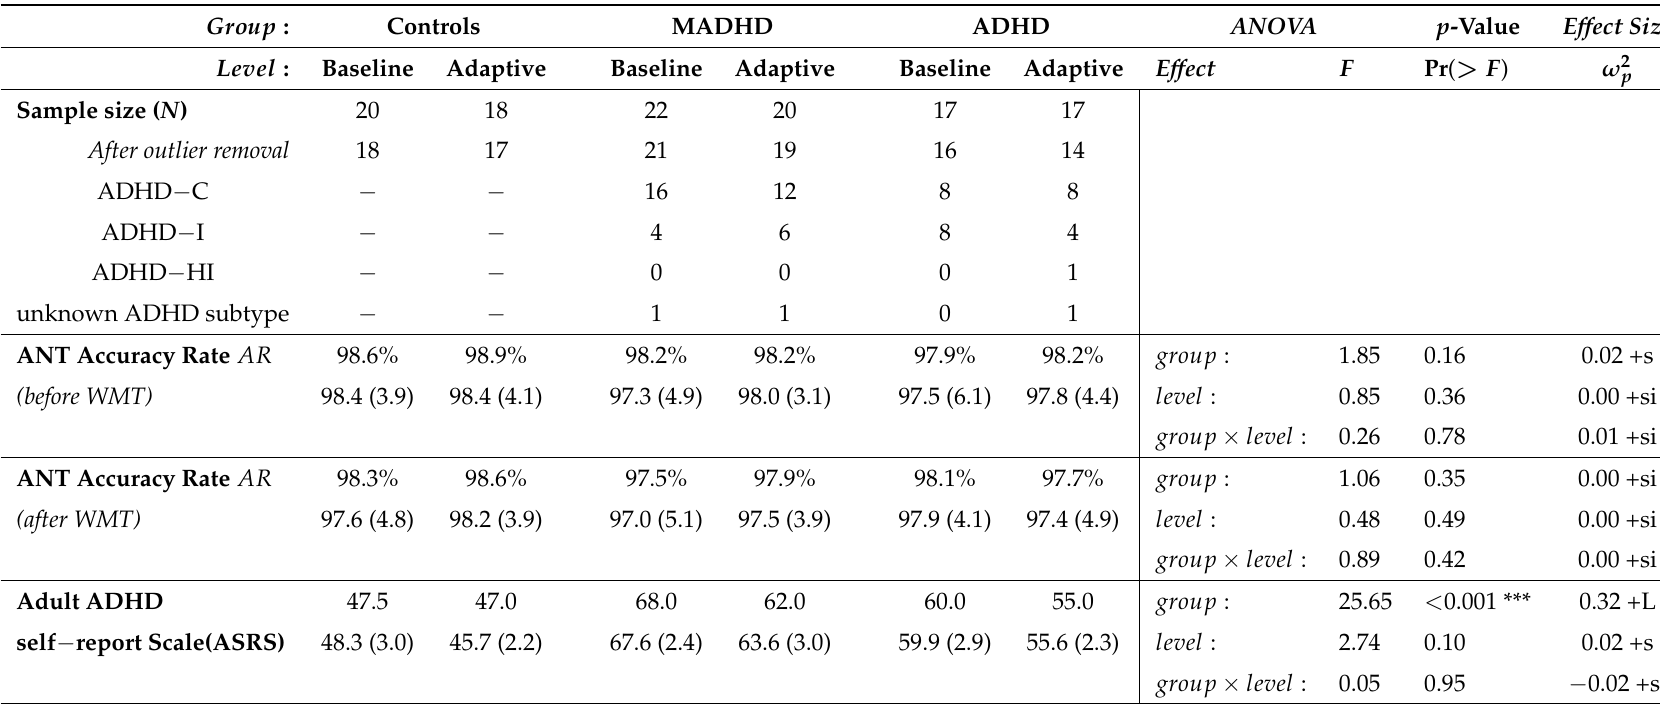
Table 1. Descriptive statistics (median, mean, and SEM) of participants’ accuracy rates of performance and DSM-IV symptom subscales. The effects of factors group and level of training were tested by a two-way analysis of variance (ANOVA). The effect size was estimated by ω 2 p . Group :